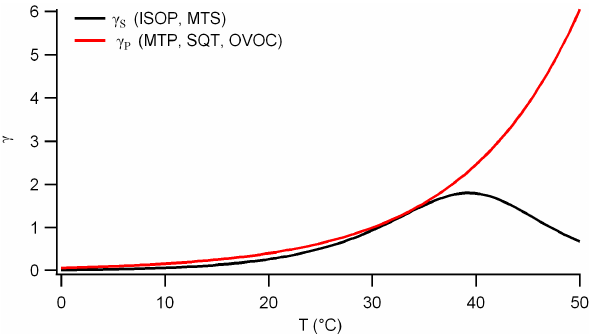
Fig. 1. Dependence of the environmental correction factors γ P and Fig. 1 : Dependence of the environmental correction factors γ P and γ S on temperature at γ S on temperature at PAR = 1000µmolm − 2 s − 1 PAR=1000µ molm − 2 s − 1 .